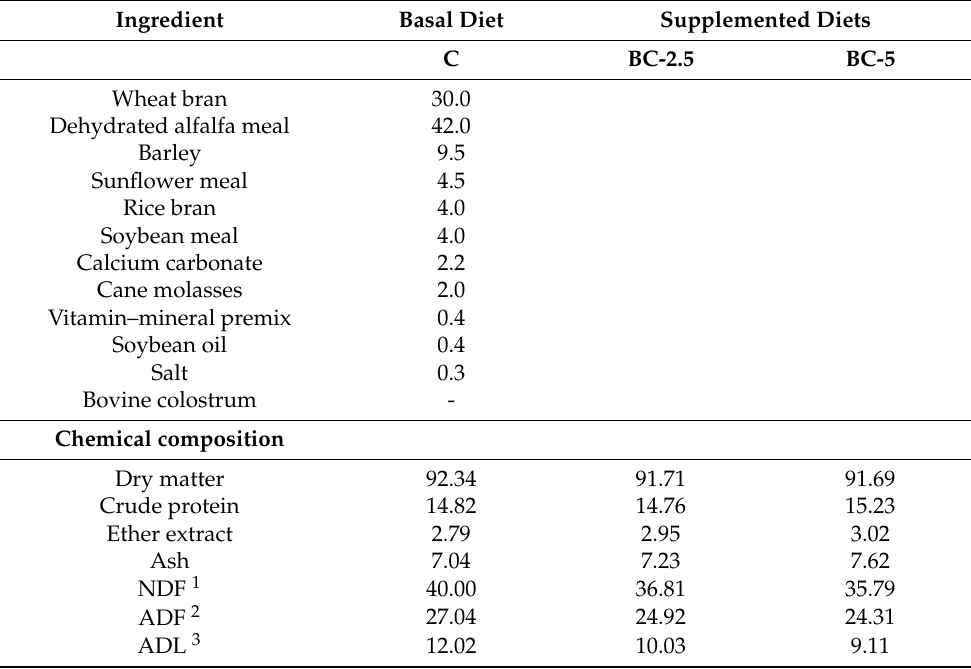
Table 1. Chemical composition of control (C) and experimental diets supplemented with 2.5% (BC-2.5) and 5% (BC-5) of bovine colostrum (% wet